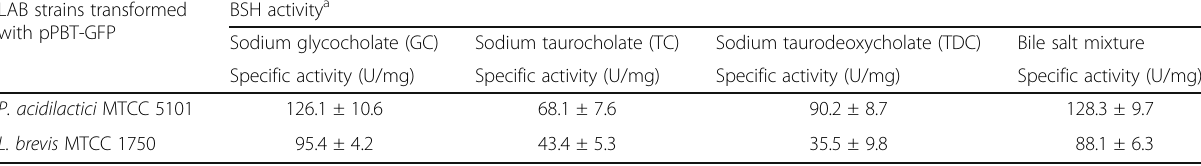
Table 5 Specific bile salt hydrolase (BSH) activity of LAB strains LAB strains transformed with